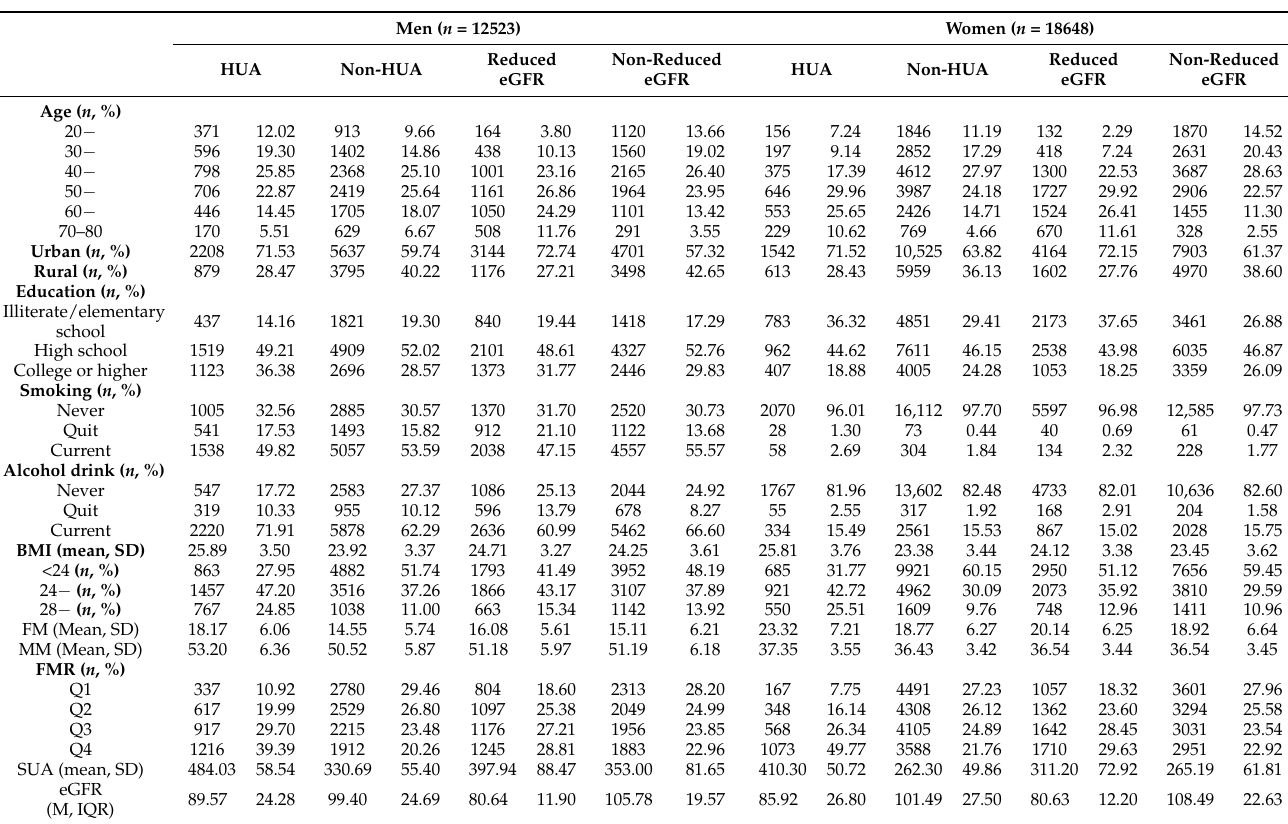
Table 1. Basic characteristics of the study population ( n =